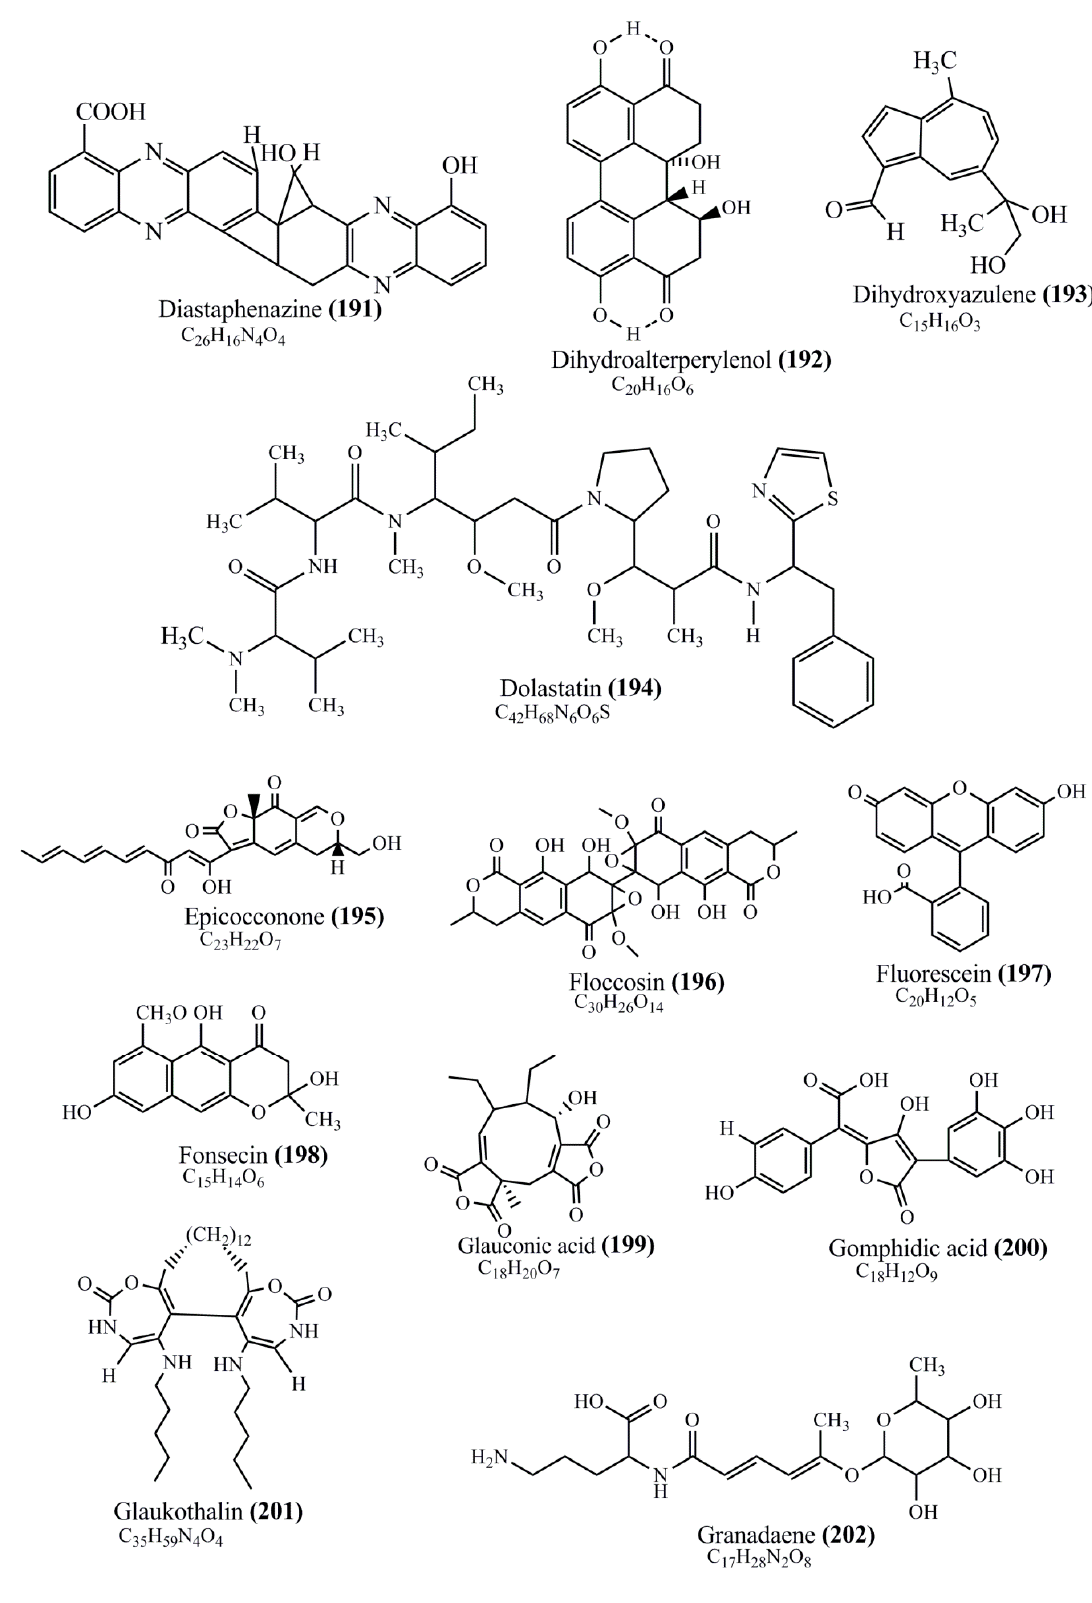
Figure 1. Figure 1. Continued.